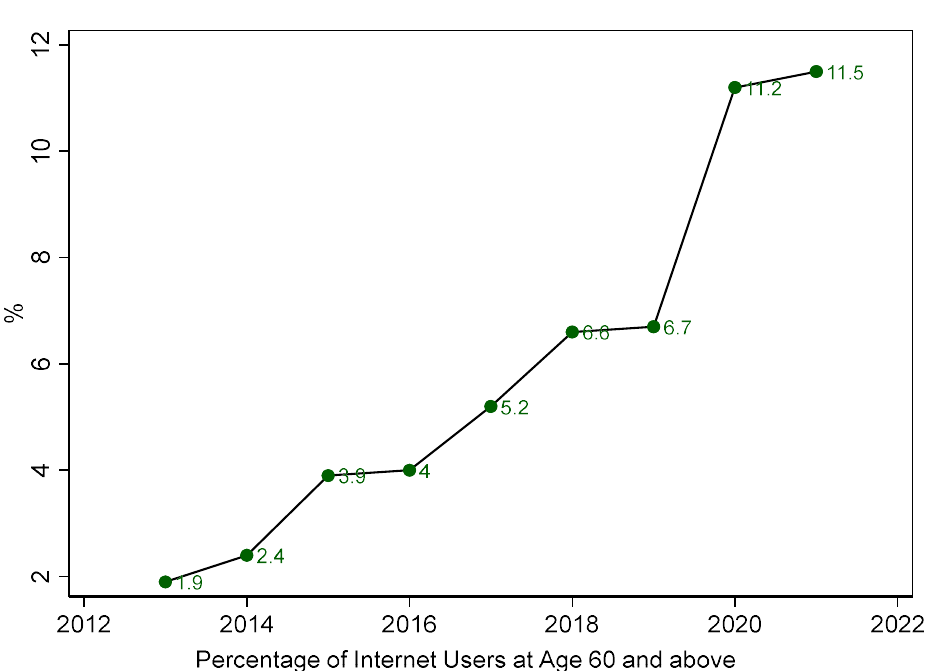
Figure A2. The rural–urban digital divide in China. Source: China Internet Network Information Center (CINIC).